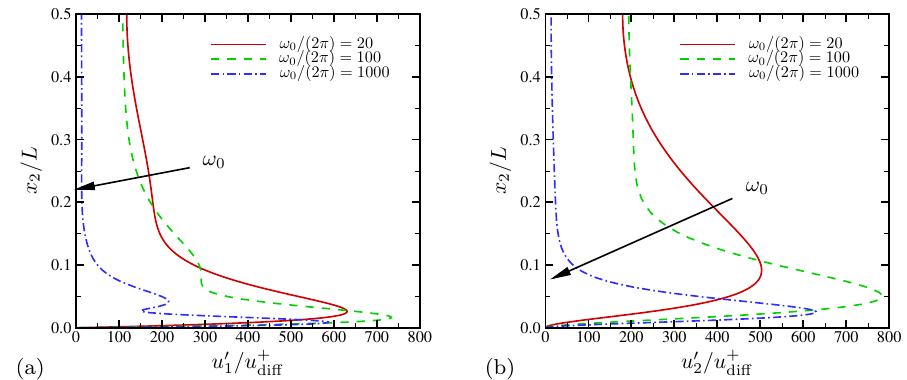
Figure 25. Rms velocity fluctuations versus wall normal coordinate for ( a ) horizontal and ( b ) wall-normal velocities. The diffusivity ratio is D − / D + = 10.